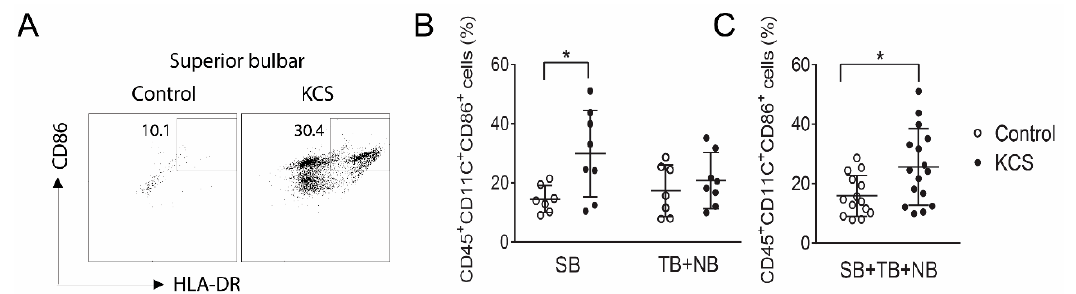
Figure 4. ( A ) Representative scatter plots of HLA-DR + CD86 + in representative control and KCS patient. ( B ) Graphs comparing percentage of CD11c + CD86 + cells in the SB and NB + TB conjunctiva in the control ( n = 7) and SS subjects ( n = 8) and ( C ) corresponding graphs for all three bulbar conjunctival sites. Data shown as scatter plots with mean ± SD. * p < 0.05 Mann–Whitney test.